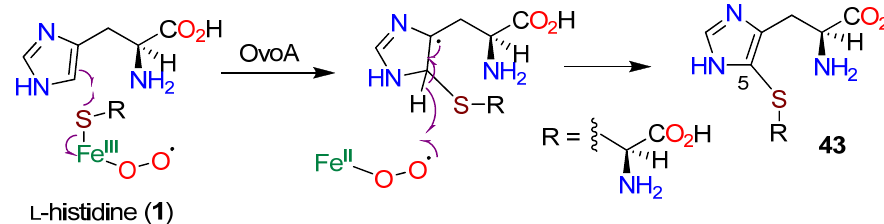
Figure 12. Reaction of L-cysteine ( 17 ) in the presence of Fe(III) (adapted from ref. [102]).